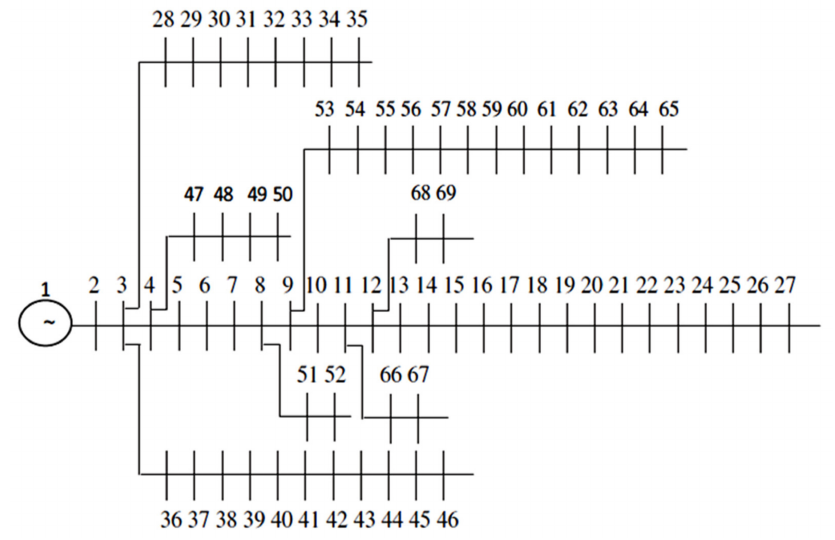
Figure 19. The schematic diagram of IEEE 69-bus radial distribution